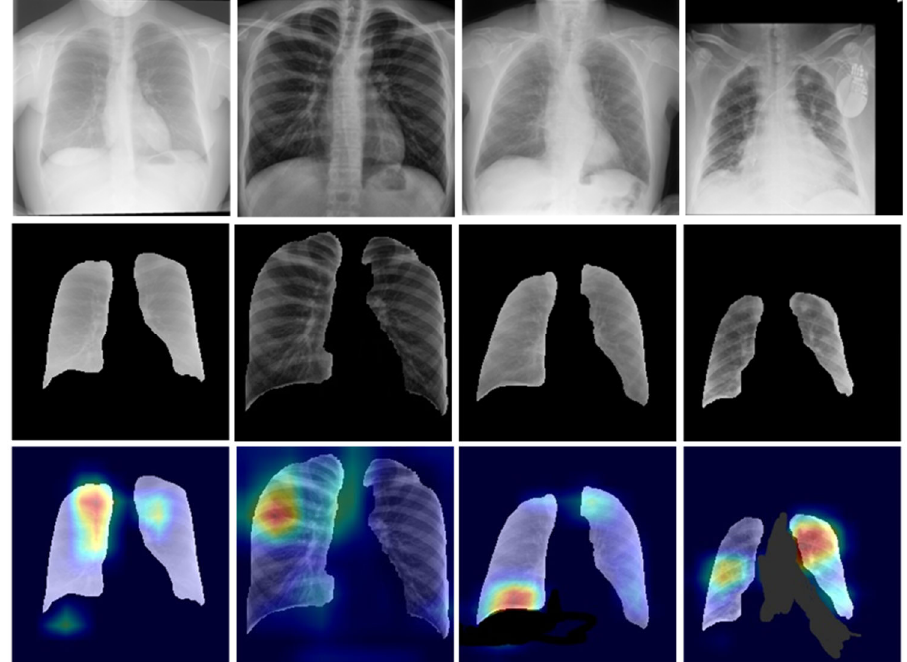
Figure 25. Example of misclassified COVID-19 chest X-ray images; top row: original COVID-19 infected chest X-ray images, middle row: segmented masks, bottom row: corresponding heat map images.